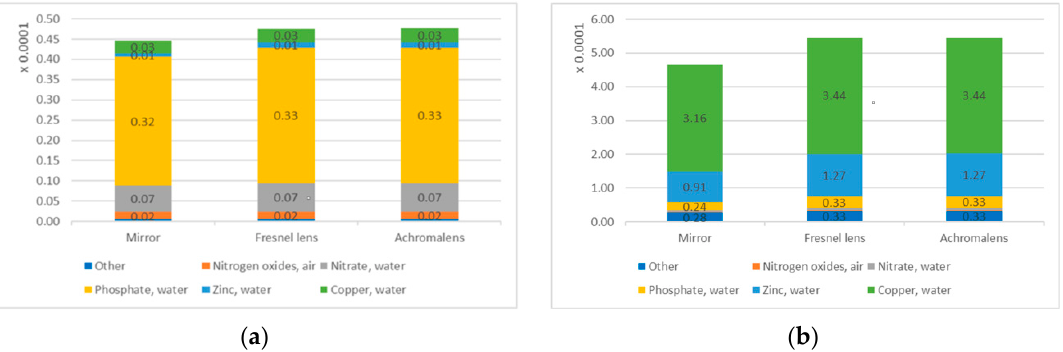
Figure 7. Normalized and weighted results of substances emitted in the environment for the three scenarios. ( a ) The left bars the results of the ILCD Midpoint+ method; ( b ) The right bars represent the results with metals freshwater ecotoxicity’s weighted results divided by 100. The results differ by a factor of 10. From left to right, the total results are 4.66 × 10 − 4 , 5.46 × 10 − 4 , and 5.47 × 10 − 4 , and 4.46 × 10 − 5 , 4.76 × 10 − 5 , and 4.76 × 10 − 5 pts.